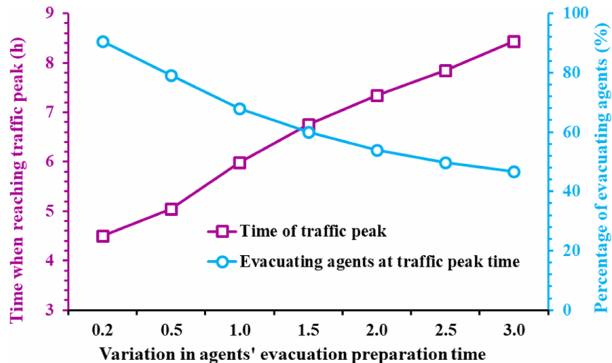
Figure 12. Peak traffic time (left y axis) and the percentage of evac- uating agents (i.e., S = 2 group) at the peak traffic time (right y axis) for various levels of human behavioral